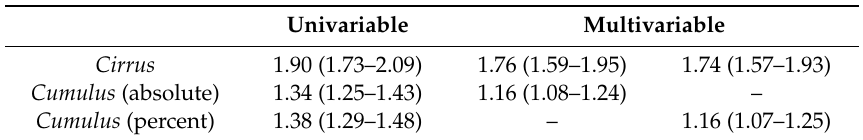
Table 4. Odds ratio per unadjusted standard deviation (OPERA 1 ) from Schmidt et al. combined data set combined data set [8].